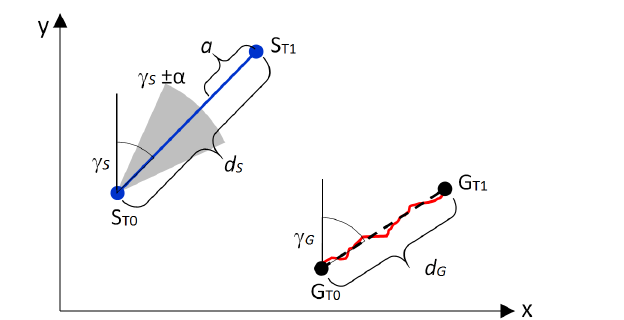
Figure 4 . Algorithm: Mode of operation